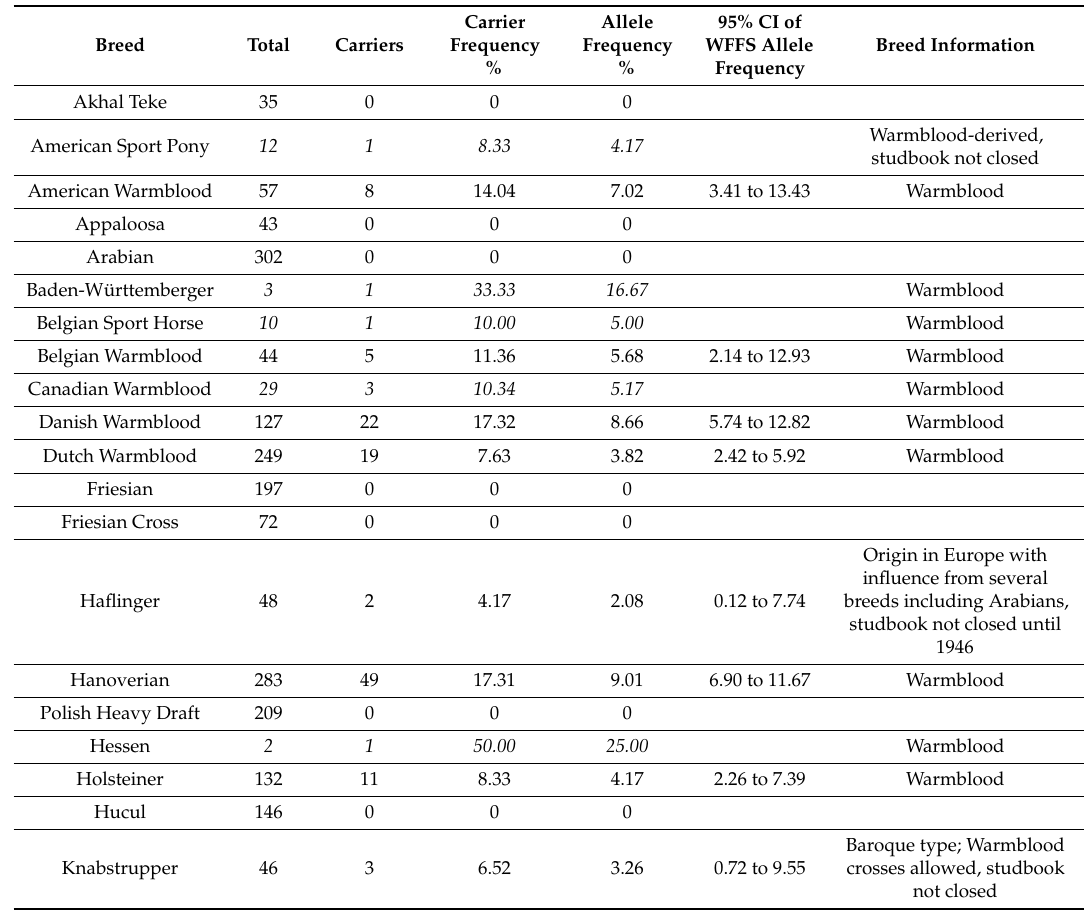
Table 1. Warmblood fragile foal syndrome (WFFS) genotyping summary for all investigated breeds with the calculated carrier frequency, allele frequency, and 95% confidence interval for allele frequency. A short breed information is given for all breeds where carriers were detected. Carrier Breed Total Carriers